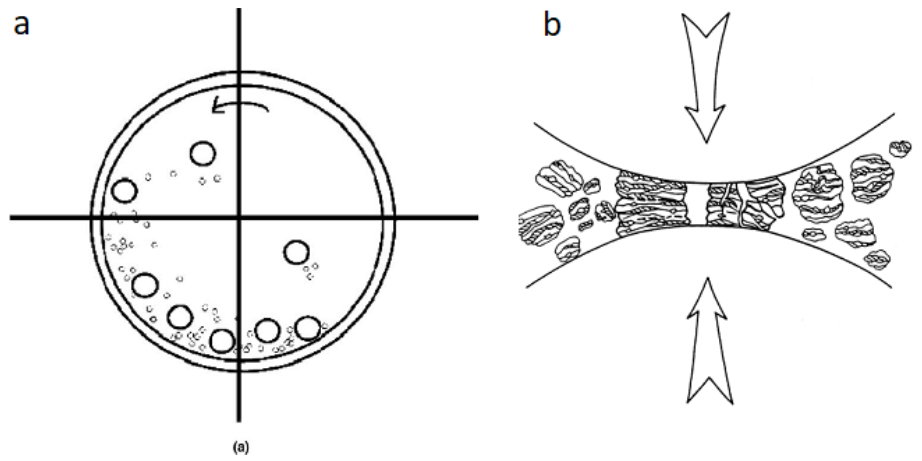
Figure 8: (a) Schematic diagram of the rotation of powders and milling balls inside the milling vial. (b) The crushing of materials as a result of ball collisions. Reproduced from Reference